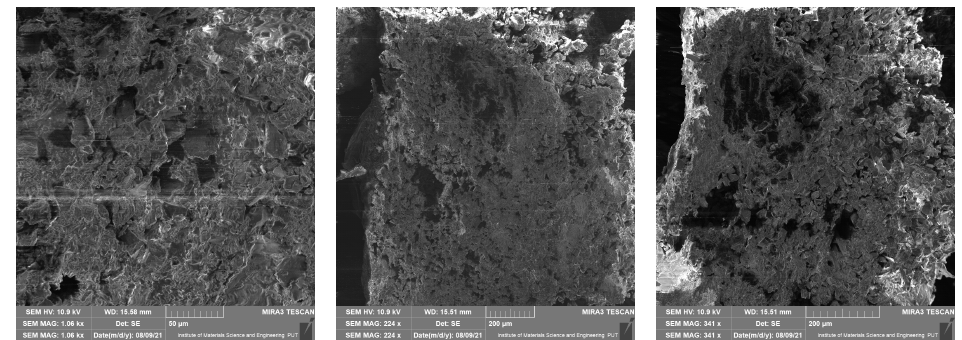
Figure 5. SEM photos for material M1.